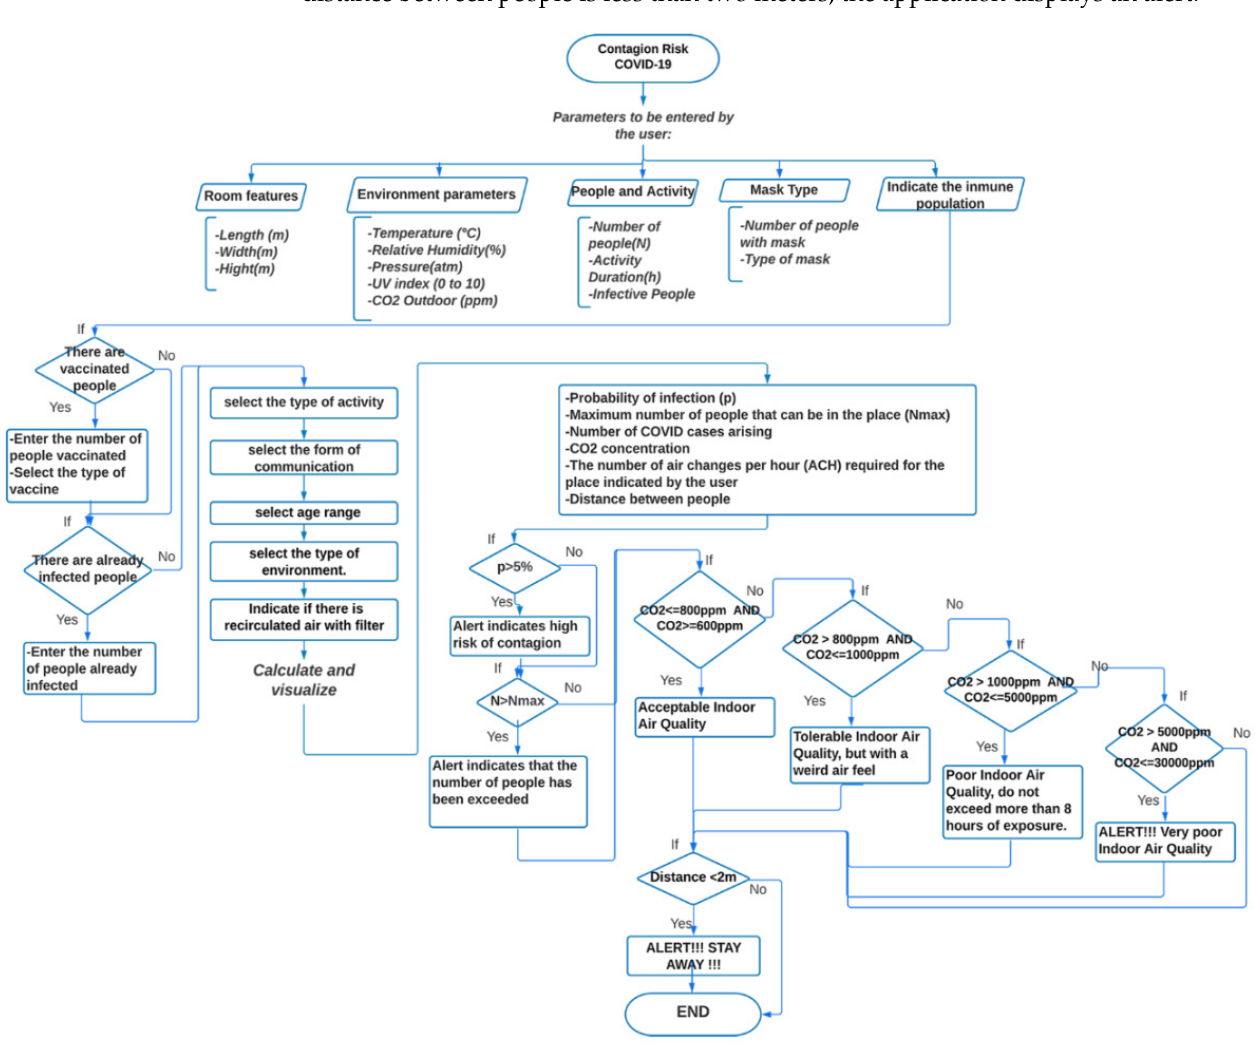
Figure 1. Flow-chart of the application for COVID-19 contagion risk estimation.